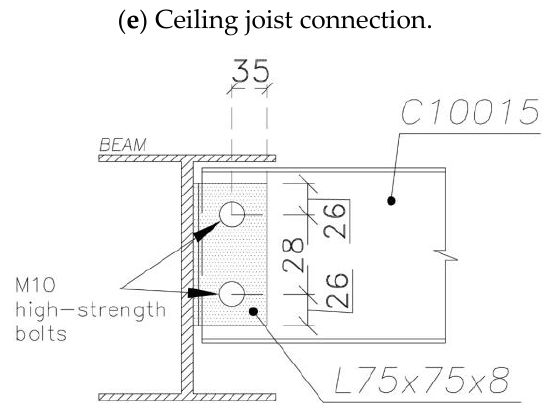
( e ) Ceiling joist connection.